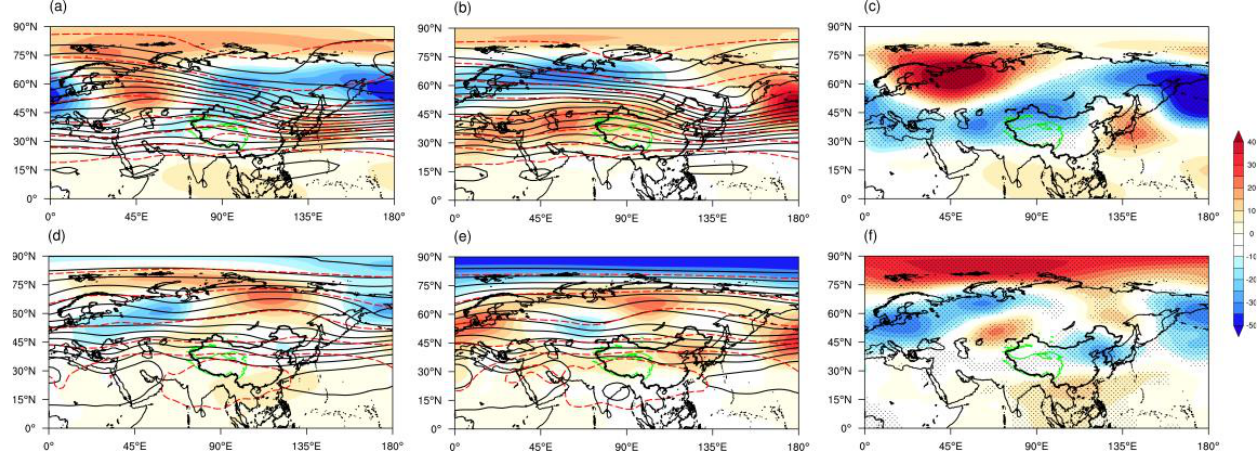
Figure 10. Same as Figure 9 but for 500 hPa in geopotential